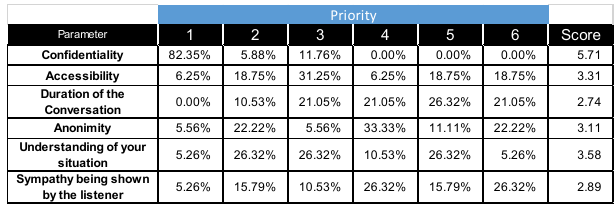
Table 1. Priorities as ranked by the